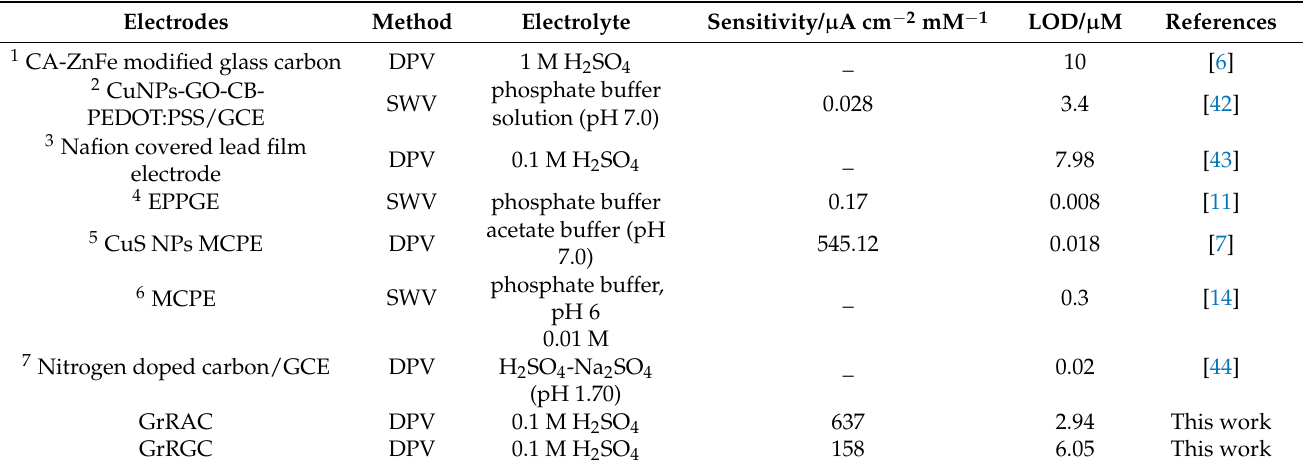
Table 2. Limit of detection of caffeine at different electrochemical